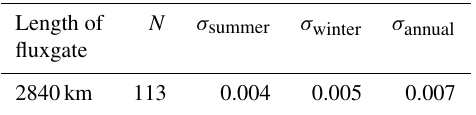
Table 1. Expected mean uncertainties in seasonal and annual sea ice area flux (10 6 km 2